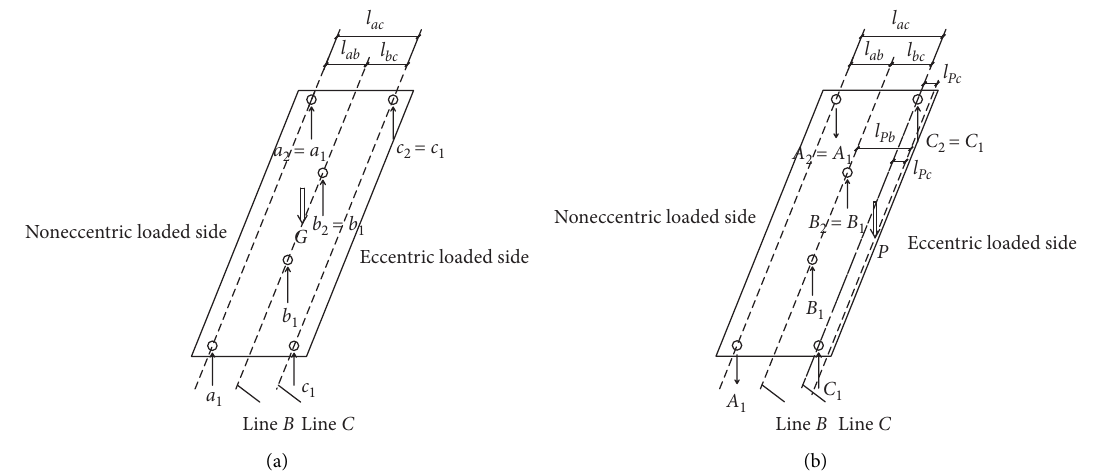
Figure 1: Vertical reactions in a single support bridge with symmetrical structural configuration and loading scheme. (a) Reactions under dead load ( G ). (b) Reactions under live load ( P )